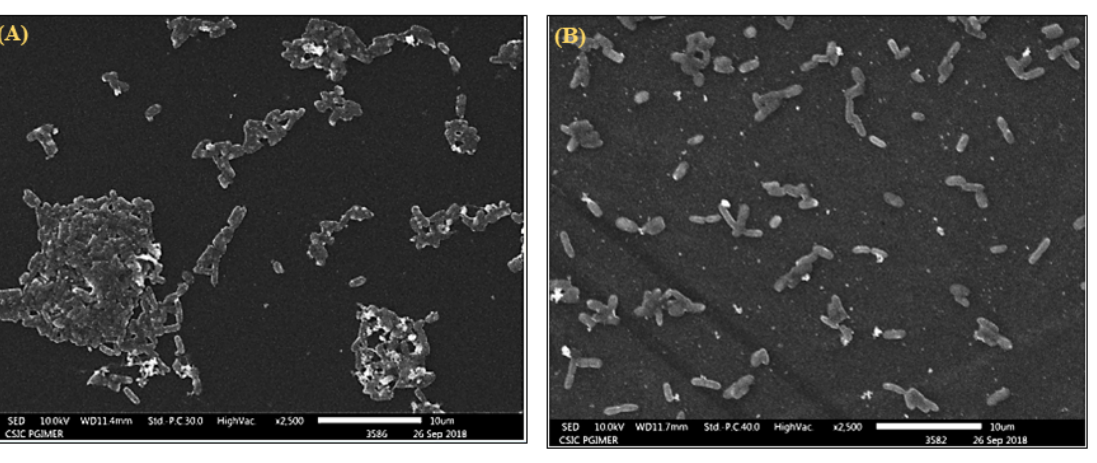
Figure 7. Scanning electron microscopic images of Escherichia coli MTCC 739 biofilms: ( A ) 24 h old control samples and ( B ) treated with heraclenol. Heraclenol was used at MIC value.